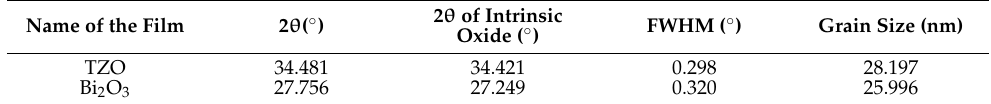
Table 3. Parameters of XRD diffraction peaks and grain sizes of TZO and Bi 2 O 3 films.